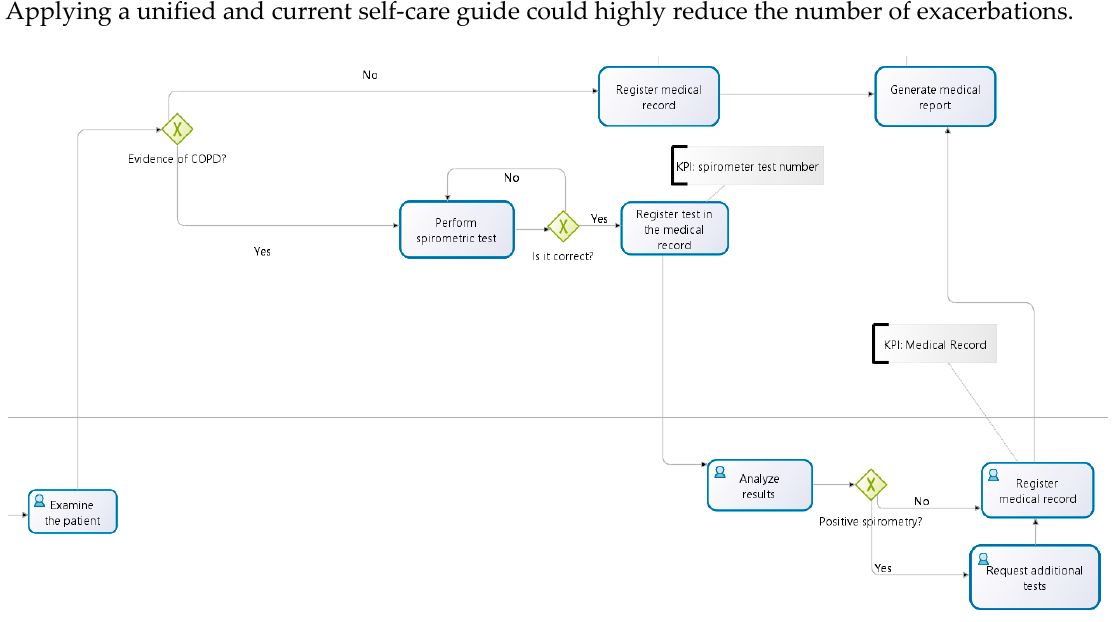
Figure 4. Registration of clinical records and